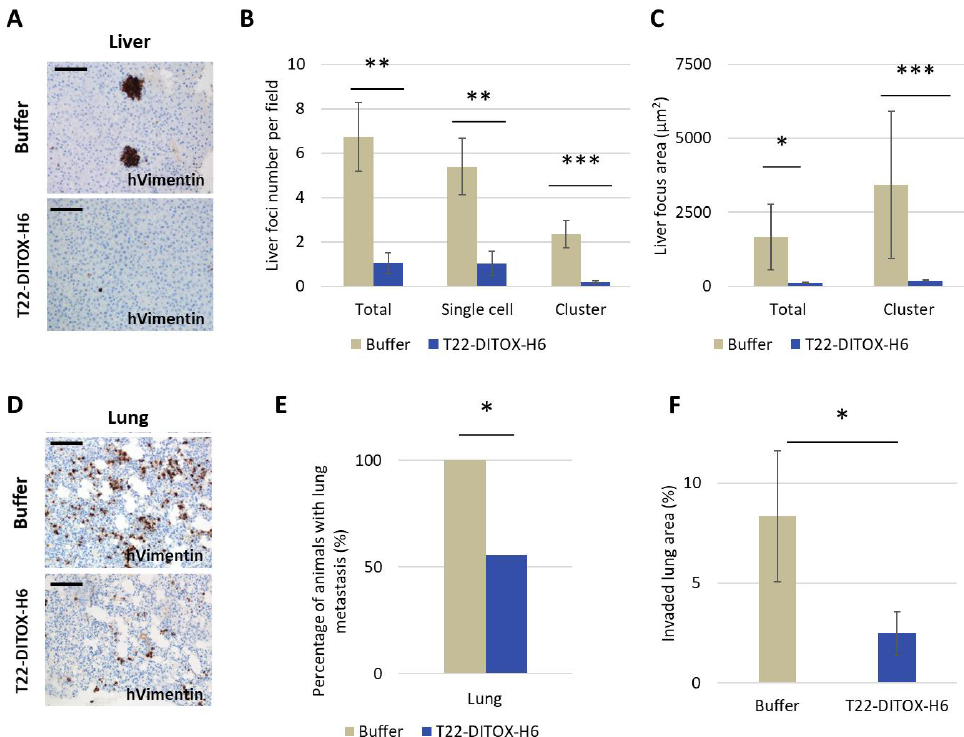
Figure 7. Antimetastatic effect measured by IHC detection of human cancer cells in liver and lung tissues after T22-DITOX-H6 repeated dose treatment in a CXCR4 + AN3CA endometrial cancer model. Mice were treated with either buffer or 5 µ g T22-DITOX-H6 for a total of 14 doses. ( A ) Representative images of immunohistochemical (IHC) staining of human vimentin registered in liver tissue for each group. ( B ) Quantification of liver metastatic foci number, including total foci number and the number of cell foci or clustered cell foci (** p ≤ 0,005; *** p = 0,000; mean ± SEM; Mann–Whitney U test). ( C ) Comparison of metastatic foci area in liver occupied by all foci or only for clustered cell foci (* p = 0.023; *** p = 0.001; mean ± SEM; Mann–Whitney U test). ( D ) Representative images of IHC staining for human vimentin of lungs registered in control and treated mice. ( E ) Comparison of the percent mice displaying positive lung metastasis between control and nanotoxin-treated mice (* p = 0.041; Fisher test). ( F ) Comparison of the lung tissue area invaded by human tumor cells between control and nanotoxin-treated mice (* p = 0.038; mean ± SEM; Mann – Whitney U test). Bars: 100 μm.